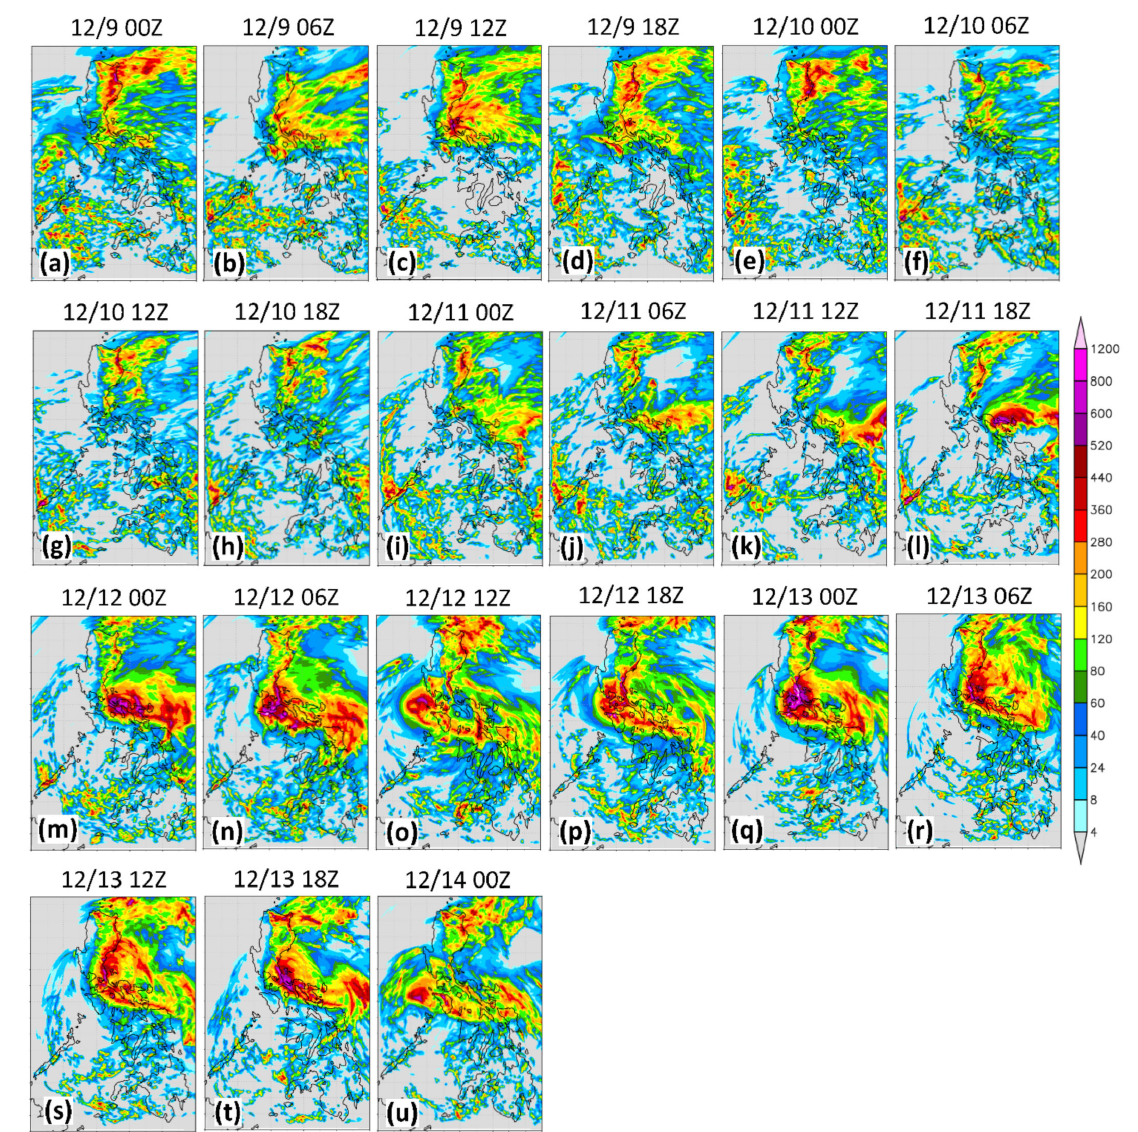
Figure 15. As in Figure 5, except for predicted 72 h rainfall distributions (mm) valid for the period from 0000 UTC on 14 to 0000 UTC on 17 December during TY Melor (2015), with the time-lagged forecasts every 6 h from ( a ) 0000 UTC on 9 to ( u ) 0000 UTC on 14 December 2015, respectively. Some panels were shown in Part I